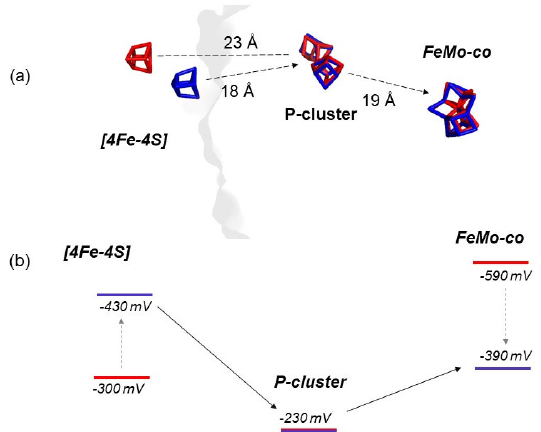
Figure 3. Structural and thermodynamic changes with ATP binding: ( a ) Changes in the position of the [4Fe-4S] in the Fe-protein with the binding of ATP. The surface of the MoFe-protein is shown. For simplicity, the surface of the Fe-protein is not shown. Red metal centres: without ATP bound. Blue metal centres: with ATP bound. With the binding of ATP, the [4Fe-4S] cluster on the Fe-protein become 5 Å closer to the p -cluster on the MoFe-protein. No change is observed in the position of the p -cluster or FeMo-co on the MoFe-protein. Figure produced by superimposing PDB structures: 2AFH and 1G21. ( b ) Changes in the redox potential of metal clusters without ATP (red) and with ATP binding (blue). Black solid arrows indicate the pathway of electrons while dashed grey arrows indicate changes in the redox potential of the metal centres. The [4Fe-4S] cluster becomes more negative (from − 300 to − 430 mV). The FeMo-co redox couple becomes more positive (from − 590 to − 390 mV) with ATP and Fe-protein binding. No change is noted in the redox potential of the p -cluster. Redox potentials determined by Minteer and co-workers [18].